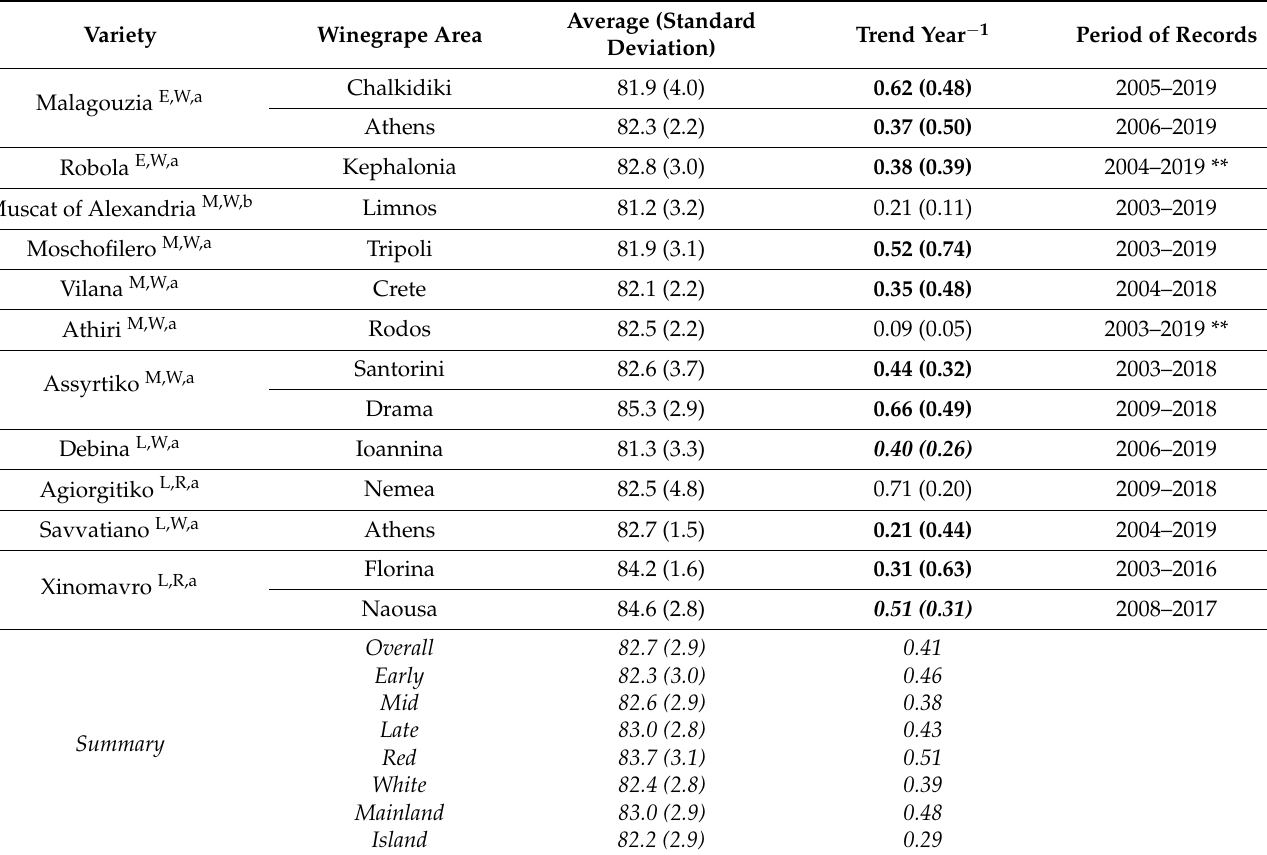
Table 4. Wine quality rating statistics and trends for the 11 principal winegrape varieties (10 in- digenous and 1 international) cultivated in 13 principal winegrape regions in Greece. Varieties and regions are presented in the first two columns. Averages and standard deviation (in parenthesis) for wine quality are given in column 3. Wine quality direction, slope and r 2 given in column 4. The period of records for each variety is given in the last